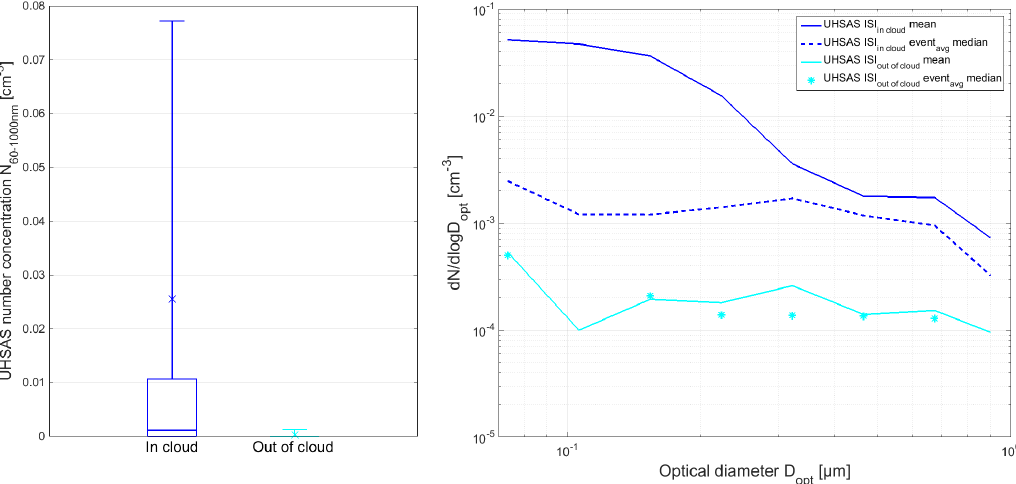
Figure 15. CLACE 2014 UHSAS measurements downstream of the ISI. The box plot (left panel) gives the mean (x), median (line in the box), 25th and 75th percentile (box edges), and the 10th and 90th percentiles (whiskers) of the 5min UHSAS total concentration measurements in cloud vs. out of cloud during the campaign. The right panel shows in-cloud and out-of-cloud size distributions during the campaign. The mean in-cloud size distribution is given by the blue line, the mean out of cloud by the cyan line, the median of the cloud event means by the dashed blue line and the median of the clear event means by the asterisk symbol (where no symbol is visible, the median is 0 and thus not seen on a log-scale